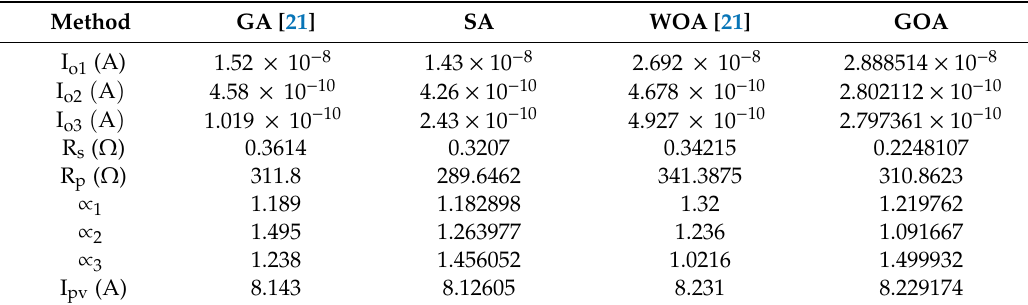
Table 2. Comparison among Optimum models for